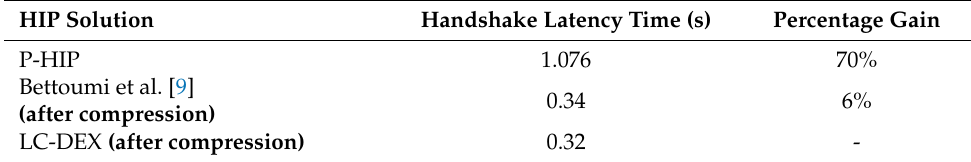
Table 12. Overall E2E delays of handshake